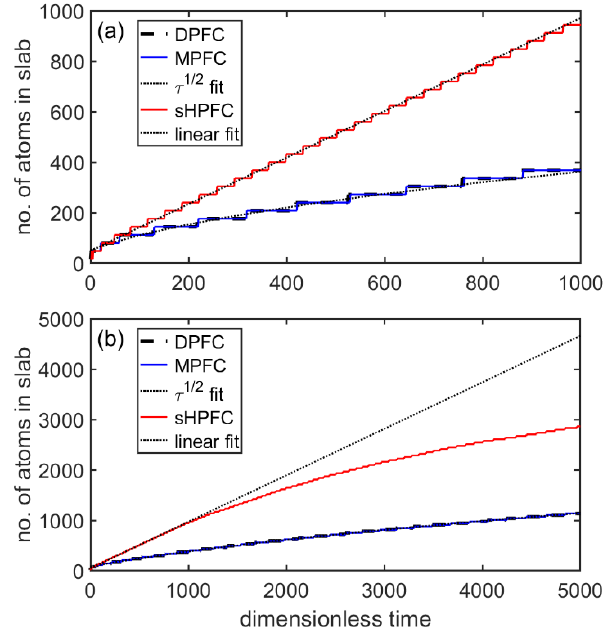
Figure 10. Flat-interface slab growth in 3D within the DPFC, MPFC ( α = 1 and β = 0), and the sHPFC model ( α = 0 and β = 1). The number of atoms in the crystalline slab is shown as a function of dimensionless time for ( a ) short times and ( b ) long times. A linear function fitted to the sHPFC result for t < 500, and an A τ 1/2 function fitted to the DPFC result for τ < 5000 are also shown (dotted lines).